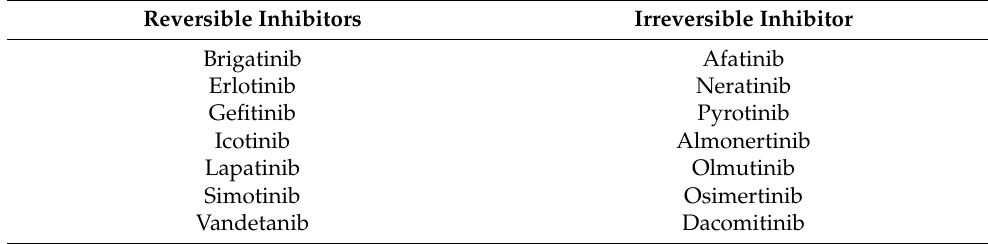
Table 2. Classification of EGFR TKIs based on the nature of inhibition of EGFR [10].